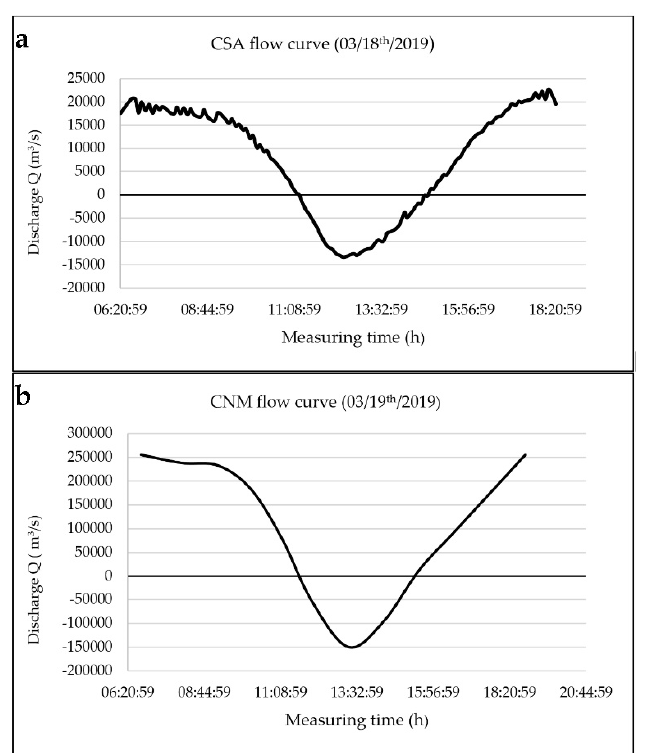
Figure 4. ( a ) CSA water discharge from the 18th of March 2019; ( b ) CNM water discharge from